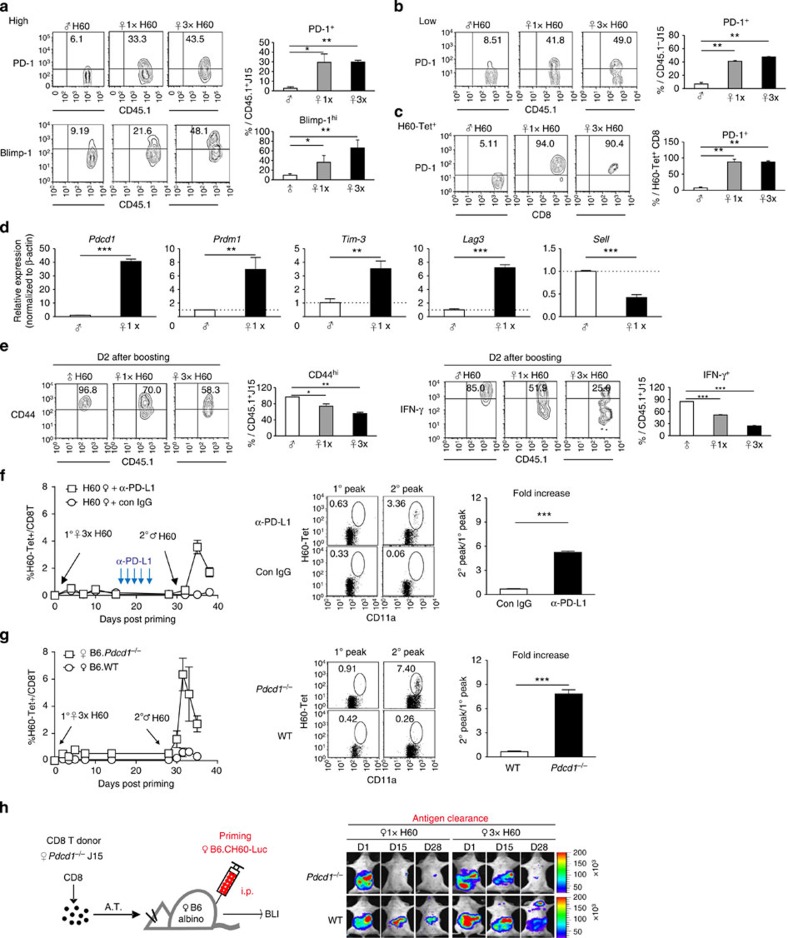
Exhaustion of H60-specific CD8+ T cells under helper-deficient conditions.(a) Flow cytometric analysis of J15 CD8+ T cells (transferred in high numbers) for expression of PD-1 and Blimp-1 on day 39 post priming (n=2 per group per experiment). (b,c) Flow cytometric analyses of (b) J15 CD8+ T cells transferred in low numbers and (c) polyclonal H60-tetramer-binding CD8+ T cells on day 39 post priming. Percentages of the positive population are plotted (n=2 per group). (d) Real-time quantitative RT–PCR analysis to determine relative expression levels of Pdcd1 (PD-1), Prdm1 (Blimp-1), Tim-3 (Tim-3), Lag3 (Lag3) and Sell (CD62L). RNA was isolated from splenic J15 CD8+ T cells in helped or helper-deficient adoptive hosts transferred in high numbers on day 39 post priming. Delta–delta Ct values were normalized to those obtained from amplification of β-actin and were expressed as fold changes compared with helped J15 gene profiles. Data represent the means±s.e.m. of two independent experiments (n=5 per group). (e) Expressions of CD44 and IFN-γ by J15 CD8+ T cells on day 2 post boosting of the adoptive hosts transferred in high numbers. Percentages of positive cells in CD45.1+J15 CD8+ T cells are plotted (n=2 per group). (f) Helper-deficient primed mice were treated with anti-PD-L1 mAb or control Rat IgG2b once every 3 days from day 14 post priming (five times). The primed-and-antibody-treated mice were boosted on day 40 post priming (n=3 per group). (g) Female PD-1-deficient or WT B6 mice were challenged according to the tolerizing and boosting schedules (n=3 per group). (f,g) Longitudinal flow cytometric analysis of PBLs was performed and flow cytometric data obtained on day 10 post priming (1o peak) and day 7 post boosting (2o peak) are presented with plots of fold change in frequencies of H60-tetramer-binding CD8+ T cells. (h) BLI analysis of antigen clearance. B6-albino hosts adoptively transferred (A.T.) with Pdcd1−/− or WT J15 CD8+ T cells were monitored periodically after 1 × or 3 × helper-deficient priming with B6.CH60-LucTg cells (n=2 per group). Data shown represent two (b–f) or at least three (a,g,h) independent experiments. Data are presented as means±s.e.m. *P<0.05, **P<0.01, ***P<0.001 determined by Student's t-test.